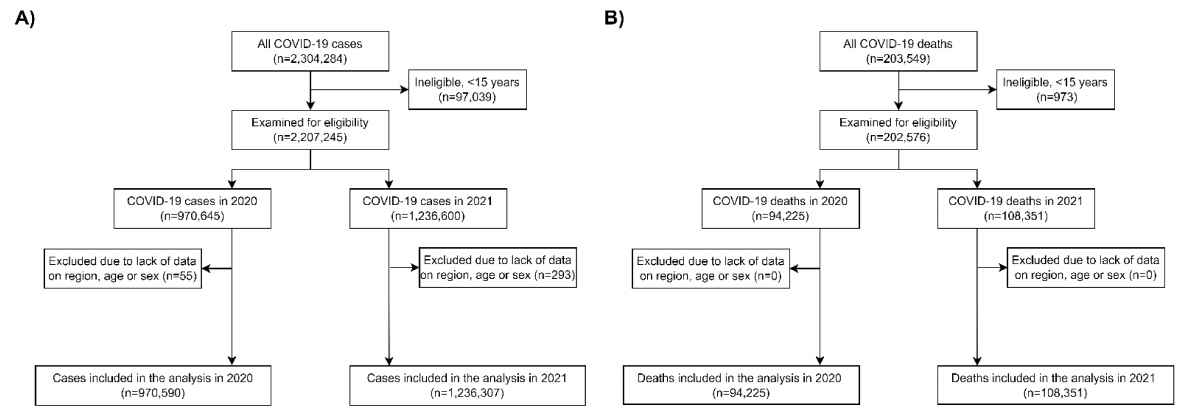
Figure 1. Study flow chart using the STROBE reporting guidelines. COVID-19 cases ( A ) and deaths ( B ) included in the analysis for 2020 and